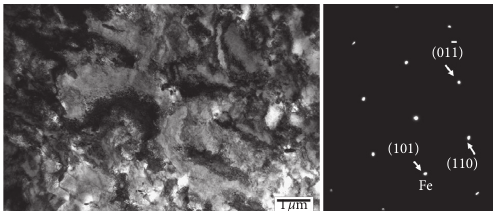
Figure 9: Microstructures of the 2.25Cr1Mo0.25V sample made by WAAM after the heat treatment.